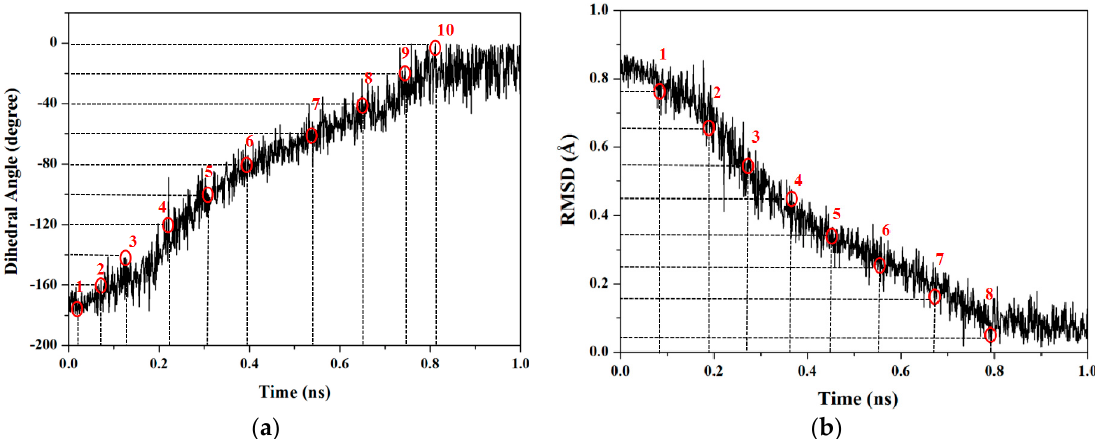
Figure 2. ( a ) The dihedral angle values of C–C–C–C and the 10 selected sampling windows; and ( b ) the root mean square deviation (RMSD) values of four C atoms and the 8 selected sampling windows from the first TMD simulation. The selected sampling windows are numbered around the red circles. The corresponding expected values and snapshots with the red circles are marked by the dash lines.